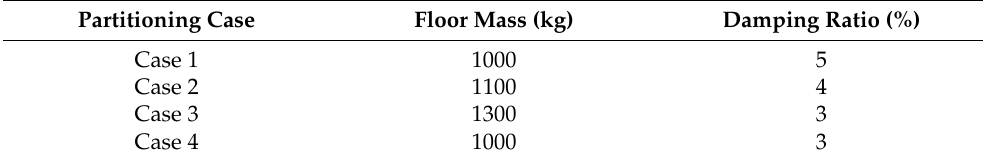
Figure 7. Force–displacement and force–velocity responses of the MR damper under sinusoidal displacement input: 5 sin2.5 π t (mm). Table 3. Four RTHS partitioning cases.